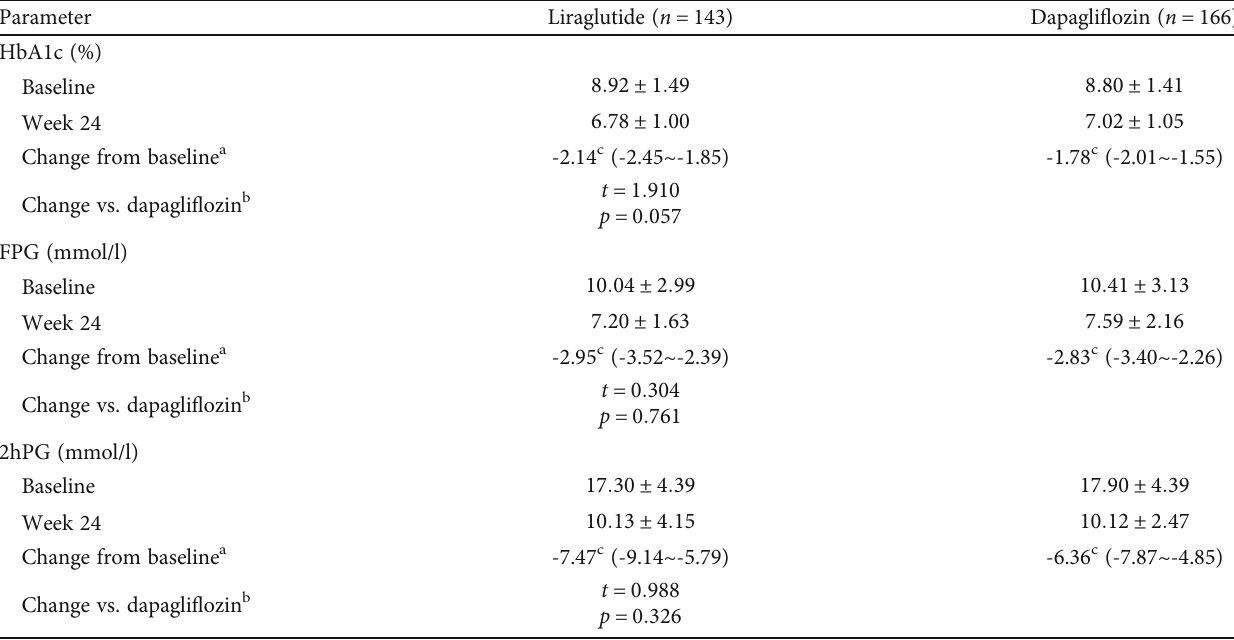
Table 2: E ffi cacy endpoints (HbA1c, FPG, and 2hPG) at week 24.